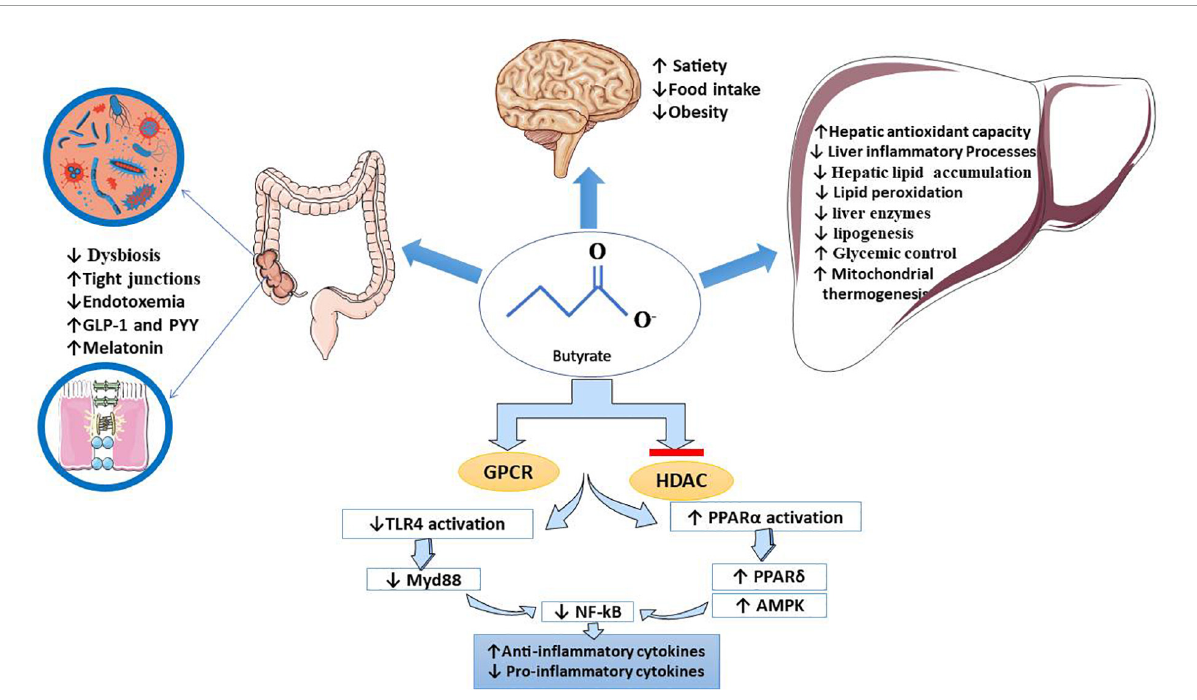
FIGURE2 Butyrate’s beneficial effects on NAFLD. It has been proved that butyrate inhibits HDAC and binds to specific GPCRs, which hereby interferes with the expression of several genes. It downregulates TLR 4/MyD88/NF-kB pathways (inhibits NF-kB translocation) and upregulates PPAR-related pathways. Butyrate, mainly through these mechanisms, contributes to the management of NAFLD. Clinical manifestation of butyrate effects on the liver, gut, and brain pictured in this figure: (1) in the liver: butyrate improves liver enzymes, lipid metabolism, glycemic control, mitochondrial thermogenesis, oxidative status, hepatic lipid accumulation, and inflammatory markers, (2) in the gut: butyrate modifies dysbiosis and microbiota, reduces endotoxemia, increases intestinal integrity, increases anorexic hormones such as PYY and GLP-1 and modulates tight junction proteins, and (3) in the brain: as a positive effect of butyrate on managing obesity, it may suppress appetite and food intake. AMPK, adenosine monophosphate-activated protein kinase; GLP1, glucagon-like peptide-1; GPCR, G-protein coupled receptor; HDAC,